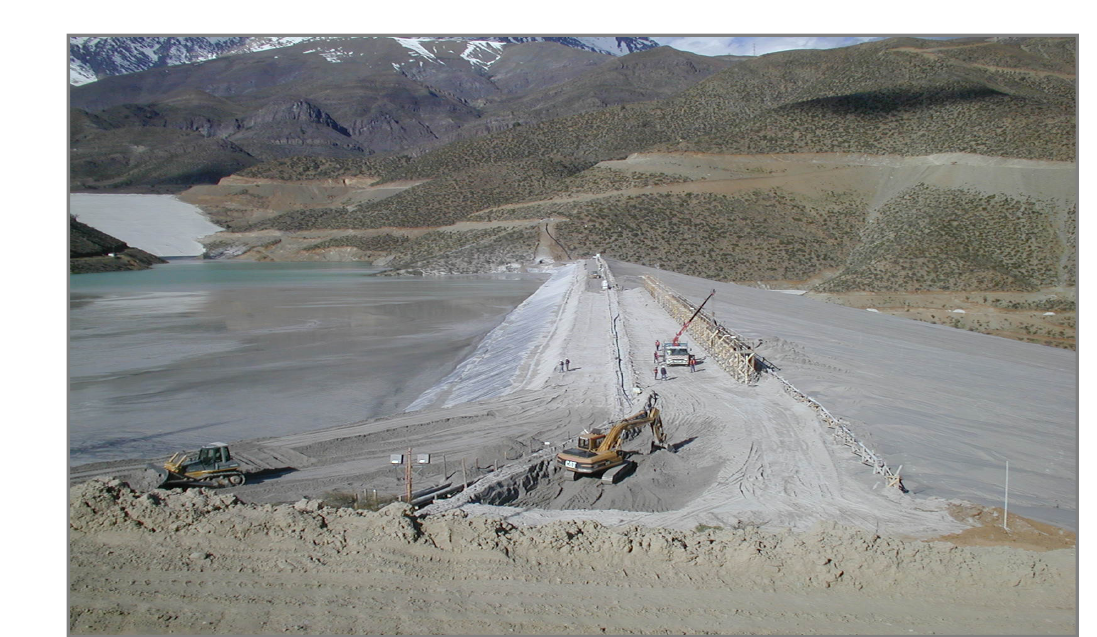
Figure 22. Cycloned tailings sand dam upstream face waterproofing construction process—TSF, Chile.